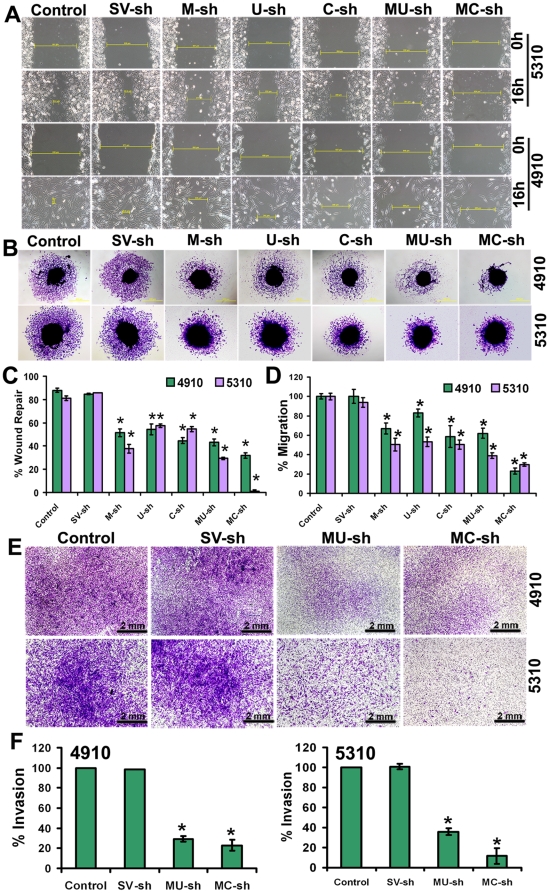
Wound healing, spheroid migration and Matrigel invasion assays.(A) Reduction in wound healing indicative of reduced migration potential was noticed after treatments with MMP-9 (M-sh), uPAR (U-sh), cathepsin B (C-sh), MMP-9/uPAR (MU-sh) and MMP-9/cathepsin B (MC-sh) plasmid shRNAs in both 4910 and 5310 cells. Untreated and SV-sh transfected cells served as controls. (B) Migration of the cells from 4910 and 5310 spheroids transfected with M-sh, U-sh, C-sh, MU-sh and MC-sh was prominently reduced. (C, D) Quantification of wound healing and spheroid migration assays. Percent wound repair was calculated from the mean of the average width of the wound obtained from 3 independent experiments. Similarly, percent migration was calculated from the mean of the average migration obtained from 3 independent experiments. Error bars indicate SEM. *p<0.05 vs. control. (E) Matrigel invasion assay of 4910 and 5310 cells transfected with SV-sh, MU-sh and MC-sh. MU-sh and MC-sh treatments prominently reduced the invasive potential of both 4910 and 5310 cells through Matrigel. (F) Invasion was quantified by counting the average number of invaded cells in five different fields with each treatment. Percent invasion was calculated from the mean of the average number of invaded cells obtained from 3 independent experiments. Error bars indicate SEM. *p<0.05 vs. control.